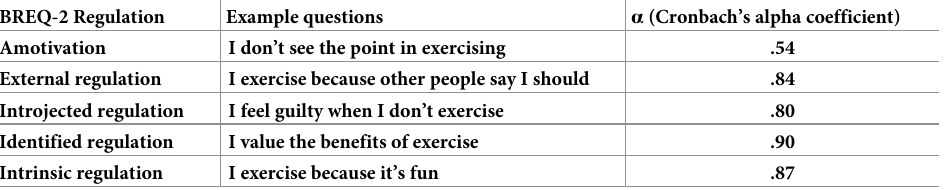
Table 3. Participant motivation to exercise.